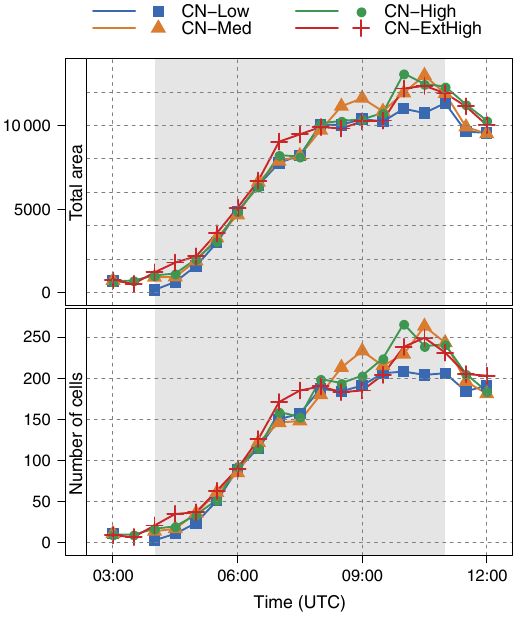
Figure 10. Total area of updraft (km 2 ) and number of updraft cells as a function of time for the CN-Low (blue), CN-Med (marigold), CN-High (green) and CN-ExtHigh (red) experiments. The volume integral of concentrations is weighted by their respective mass. The shaded area in grey represents the time period that the entire MCS is within the grid domain.